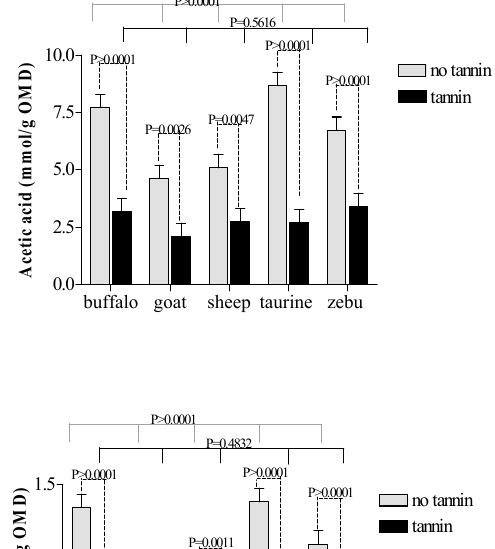
Figure 3. Effects of condensed tannin and animal species interactions on the organic matter degradability and partitioning factor during in vitro rumen fermentation.